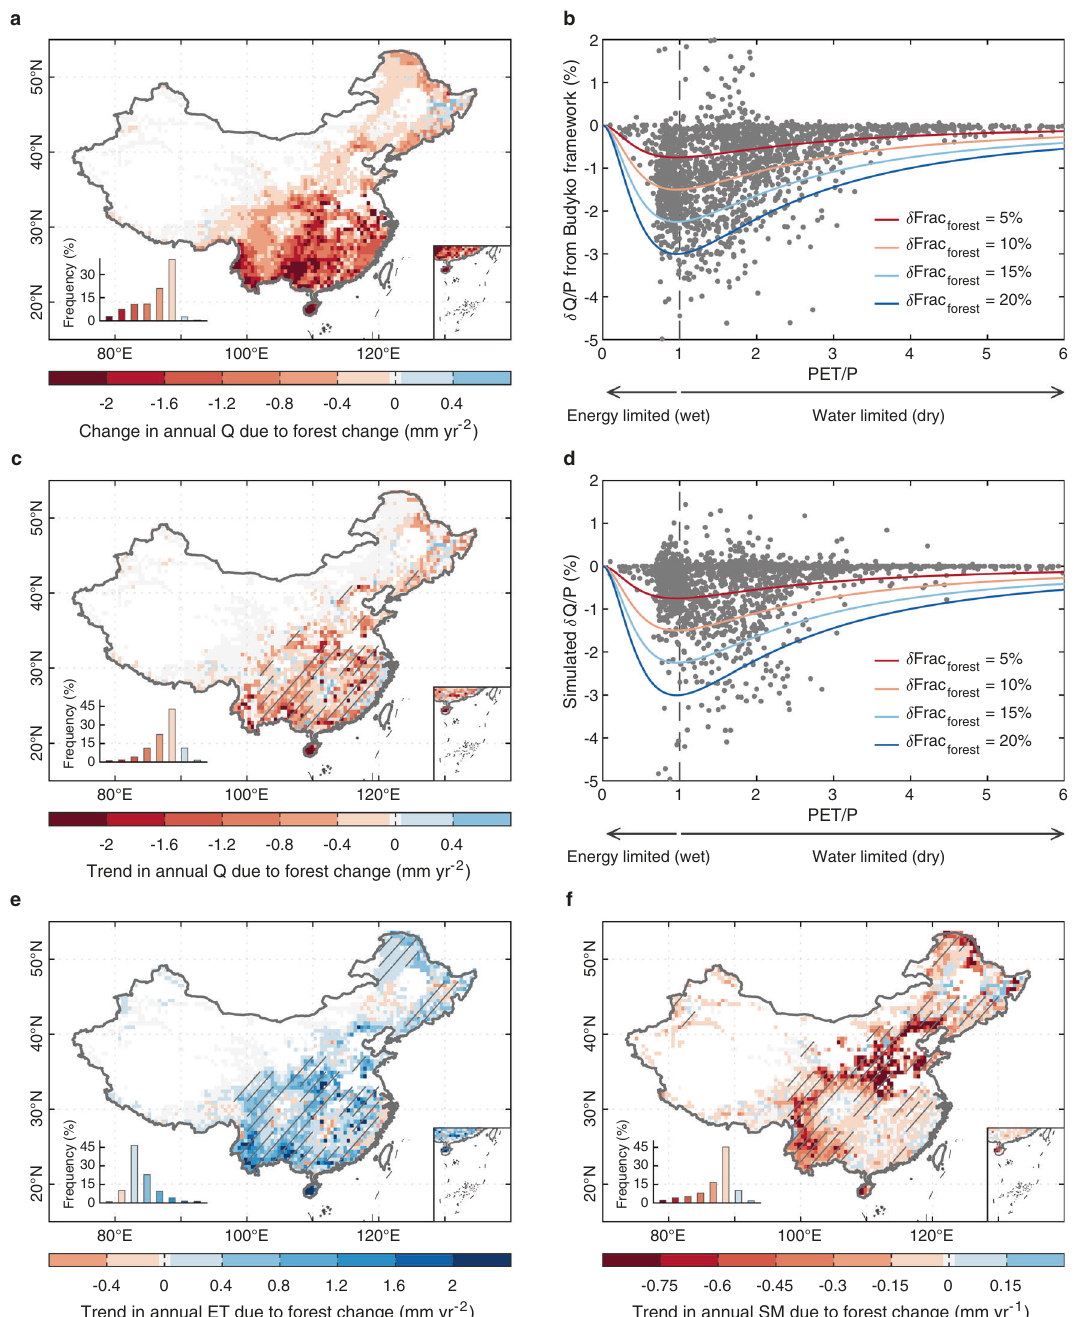
Fig. 2 Change in the hydrological cycle in response to historical forest change in China. a Change in annual runoff ( δ Q) due to forest change from 2000 to 2016 according to the Budyko framework. b Relationship between the ratio of δ Q to precipitation (P) from the Budyko framework and the ratio of potential evapotranspiration (PET) to P (PET/P) under different levels of forest gains (5, 10, 15, and 20%). The dark gray dots ( n = 2203) represent the δ Q = P due to the forest change at the grid scale, calculated as the Budyko framework. c , e , f Spatial patterns of simulated trends in Q, ET, and soil moisture (SM) due to forest change from ORCHIDEE-Hillslope. d Same as Fig. ( b ), but with the δ Q = P simulated from ORCHIDEE-Hillslope ( n = 2203). The trends in Fig. ( c ), ( e ), and ( f ) are estimated by linear least-squares regression and hatching indicates the trend is statistically signi fi cant ( t -test, p < 0.05).